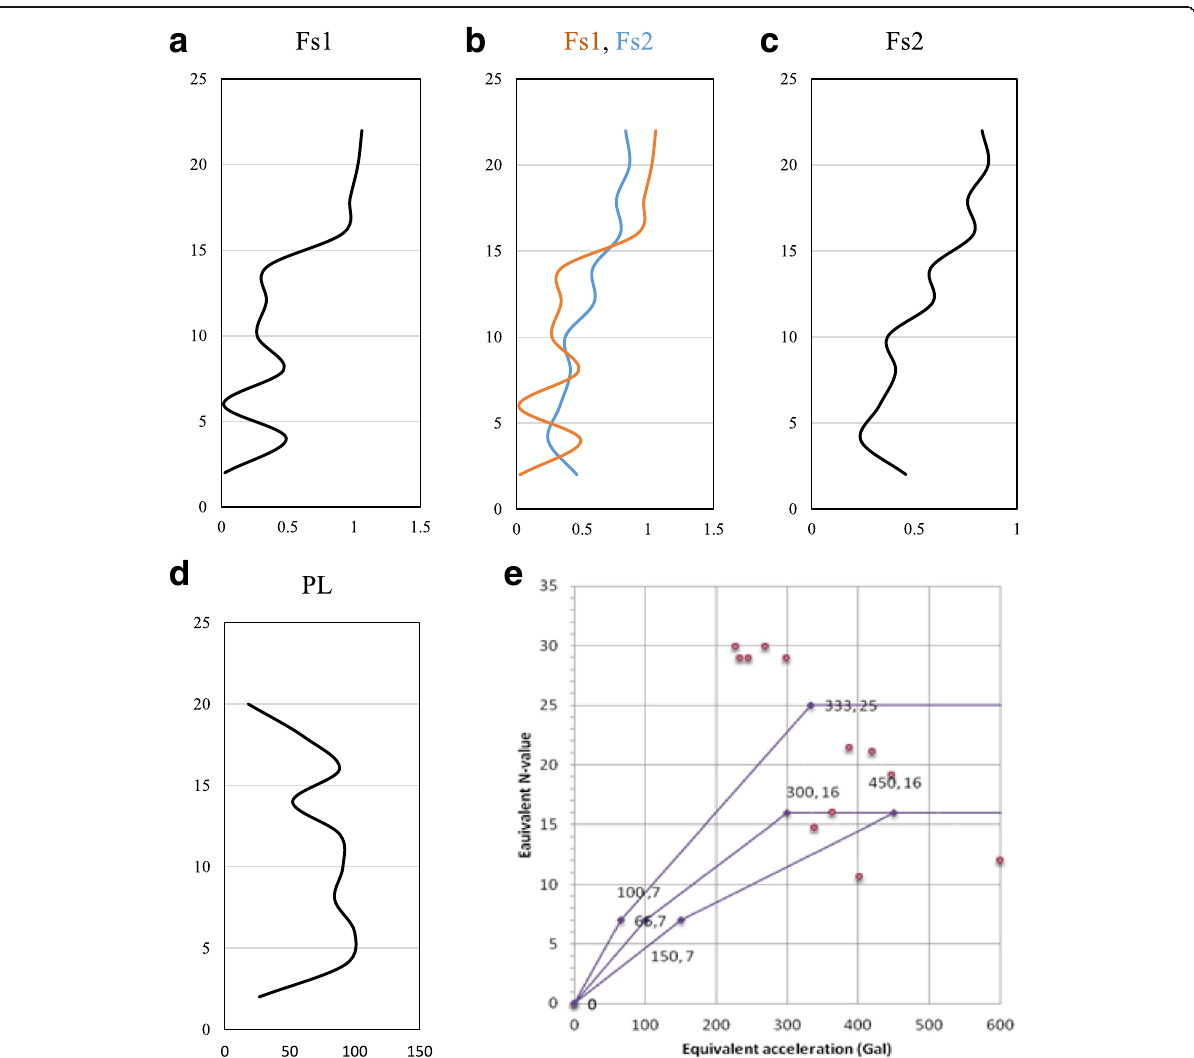
Fig. 5 Liquefaction potential evaluation related to bore